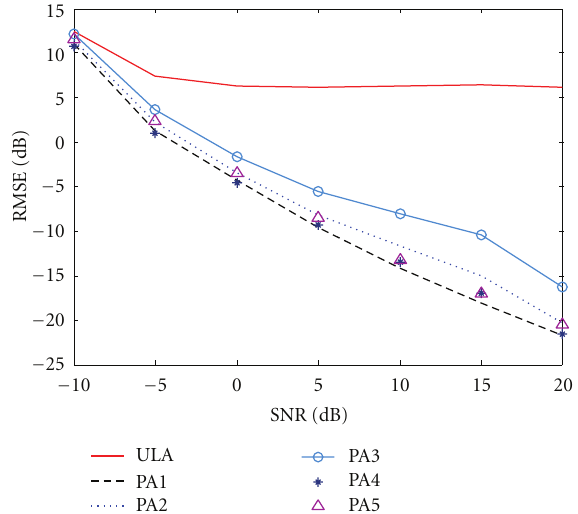
Figure 10: Total RMSE of the MUSIC algorithm for di ff erent combined array configurations in scenario 1.